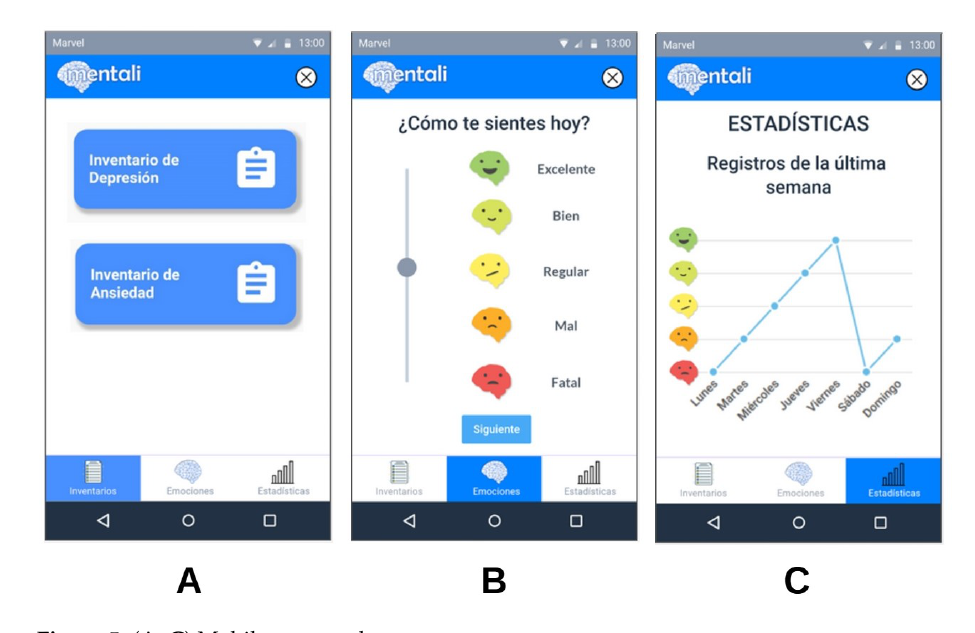
Figure 5. ( A – C ) Mobile app